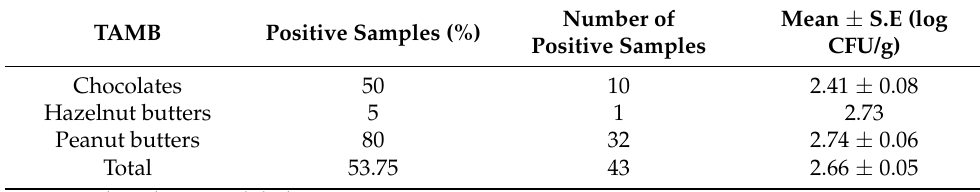
Table 4. Mean ± S.E TAMB values of positive samples of chocolates and nut